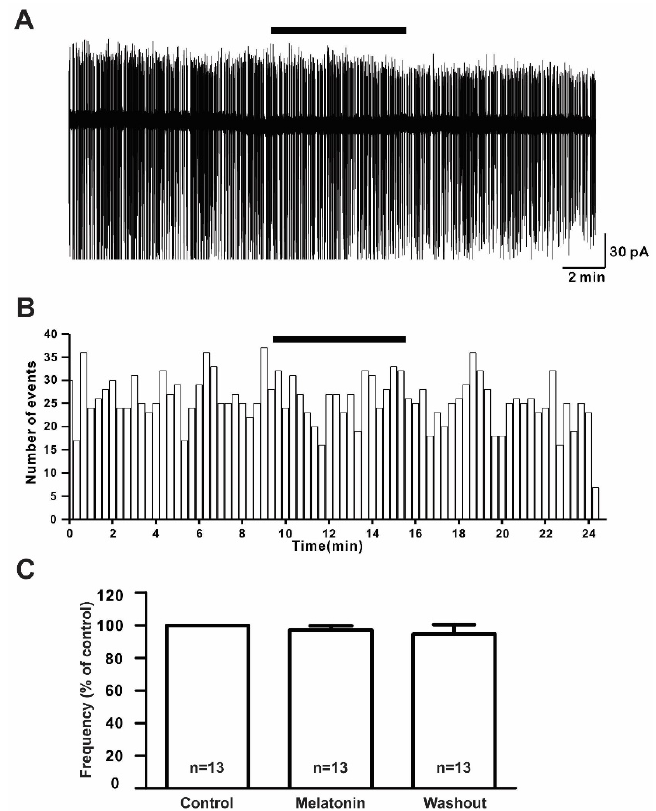
Figure 2. Melatonin did not change the firing activities of gonadotropin-releasing hormone (GnRH) neurons. ( A ) A representative trace of action currents from a GnRH neuron after 20 μM melatonin application in the cell-attached mode. The black bar represents the presence of melatonin. ( B ) Spike frequency histogram (bin size 20 s) of the current trace in Figure 2A. ( C ) Bar graph showing the firing frequency percentages in the presence and washout of melatonin ( p > 0.05; one-way ANOVA). n , the number of neurons